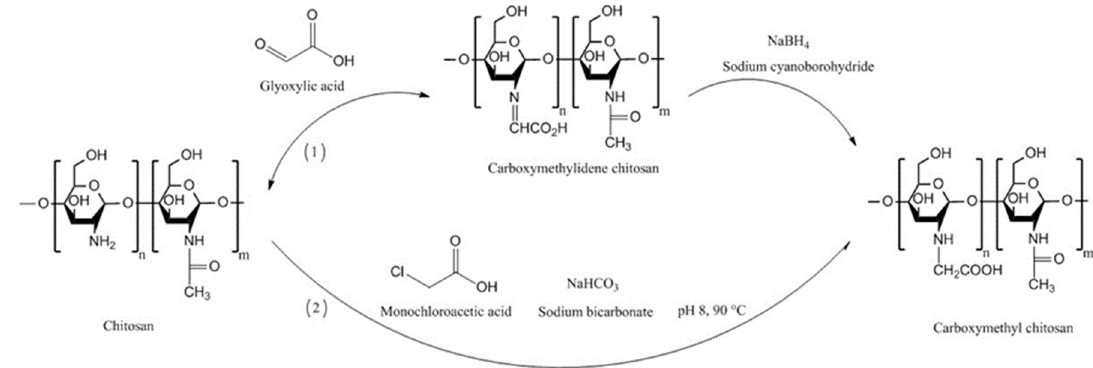
Figure 7. Schematic representation of the synthesis of carboxymethyl chitosans using reductive (1) [73] and direct (2) alkylation [79] methods.